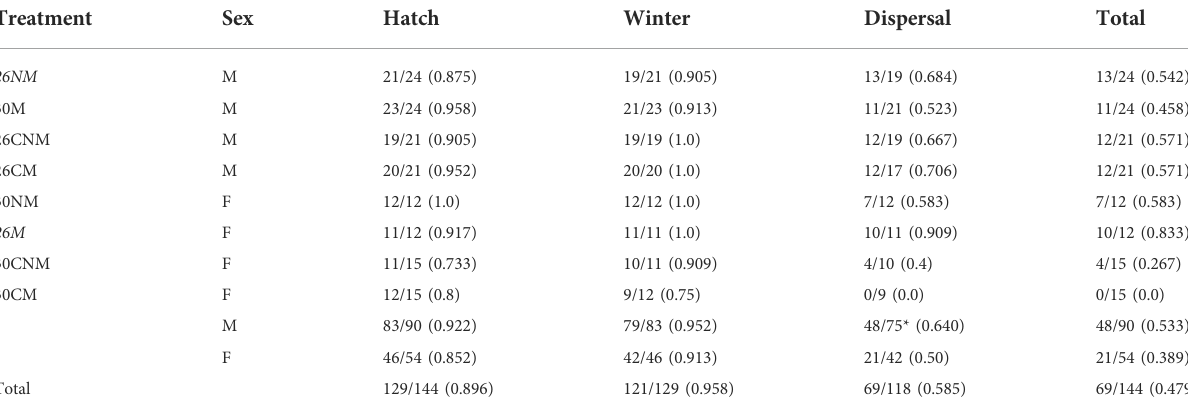
Successandsurvivalarereportedasthefraction(proportion)ofindividualshatchedoraliveattheendofagivenstagerelativetothenumberinexistenceatthestartofthatstage.The fi rst four rows correspond to treatments in the catch-up experiment of Colbert et al. (2010); treatment abbreviations are: hatchlings initially incubated at 30 ° C and moved to 26 ° C (30M), hatchlings initially incubated at 26 ° C and not moved ( 26NM ), control hatchlings initiallyincubated at 26 ° C and moved to 26 ° C (26CM), and control hatchlings initiallyincubated at 26 ° C andnotmoved(26CNM).ThenextfourrowscorrespondtotreatmentsinthewaitexperimentofColbertetal.(2010);treatmentabbreviationsare:hatchlingsinitiallyincubatedat26 ° Cand moved to 30 ° C ( 26M ), hatchlings initially incubated at 30 ° C and not moved (30NM), control hatchlings initially incubated at 30 ° C and moved to 30 ° C (30CM), and control hatchlings initiallyincubatedat30 ° Candnotmoved(30CNM).Thetwotreatmentshypothesizedtoresultinreducedsurvivorshipareitalicized.*indicatesoneturtlefailedtodepartitsnesticleandis excluded here from accounting.